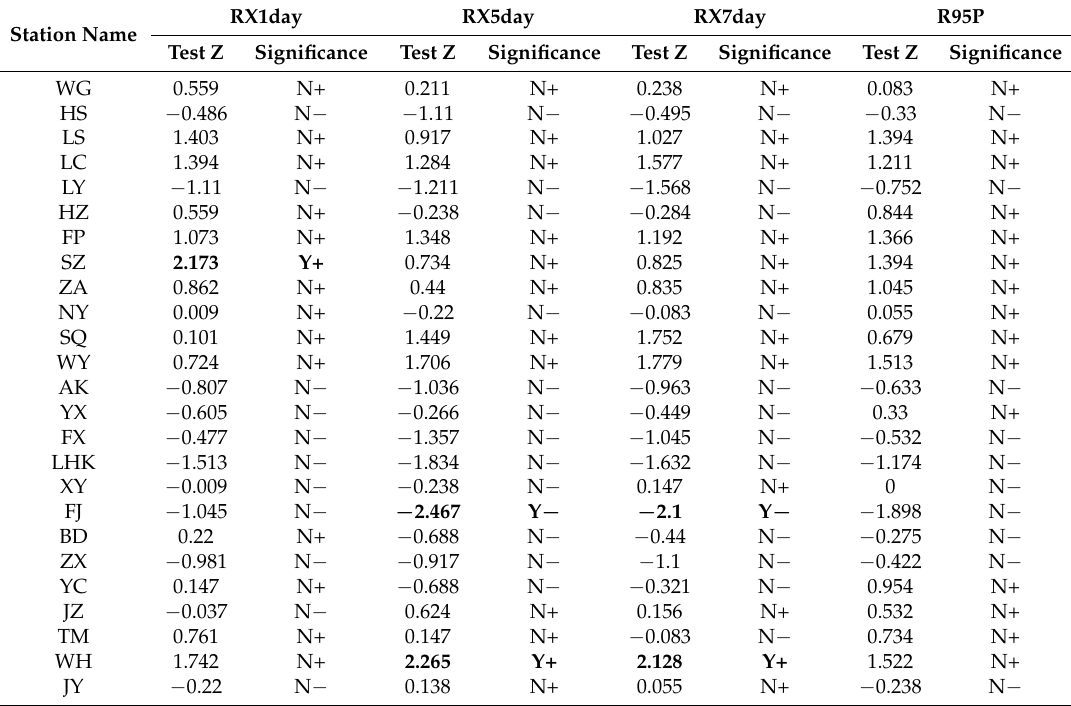
Table 2. Results of trend test for the precipitation extremes (RX1day, RX5day, RX7day and R95P) over the period (1969–2015) in the Hanjiang River Basin (HJRB) using MK